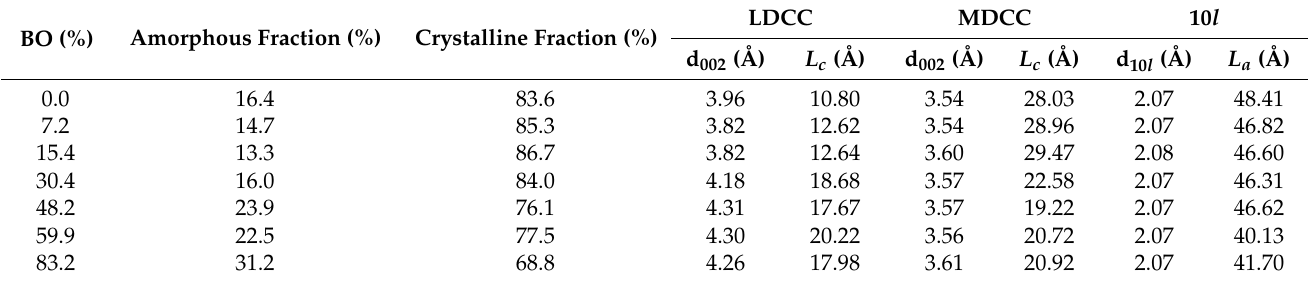
Table 3. Structural parameters of activated carbon blacks obtained from